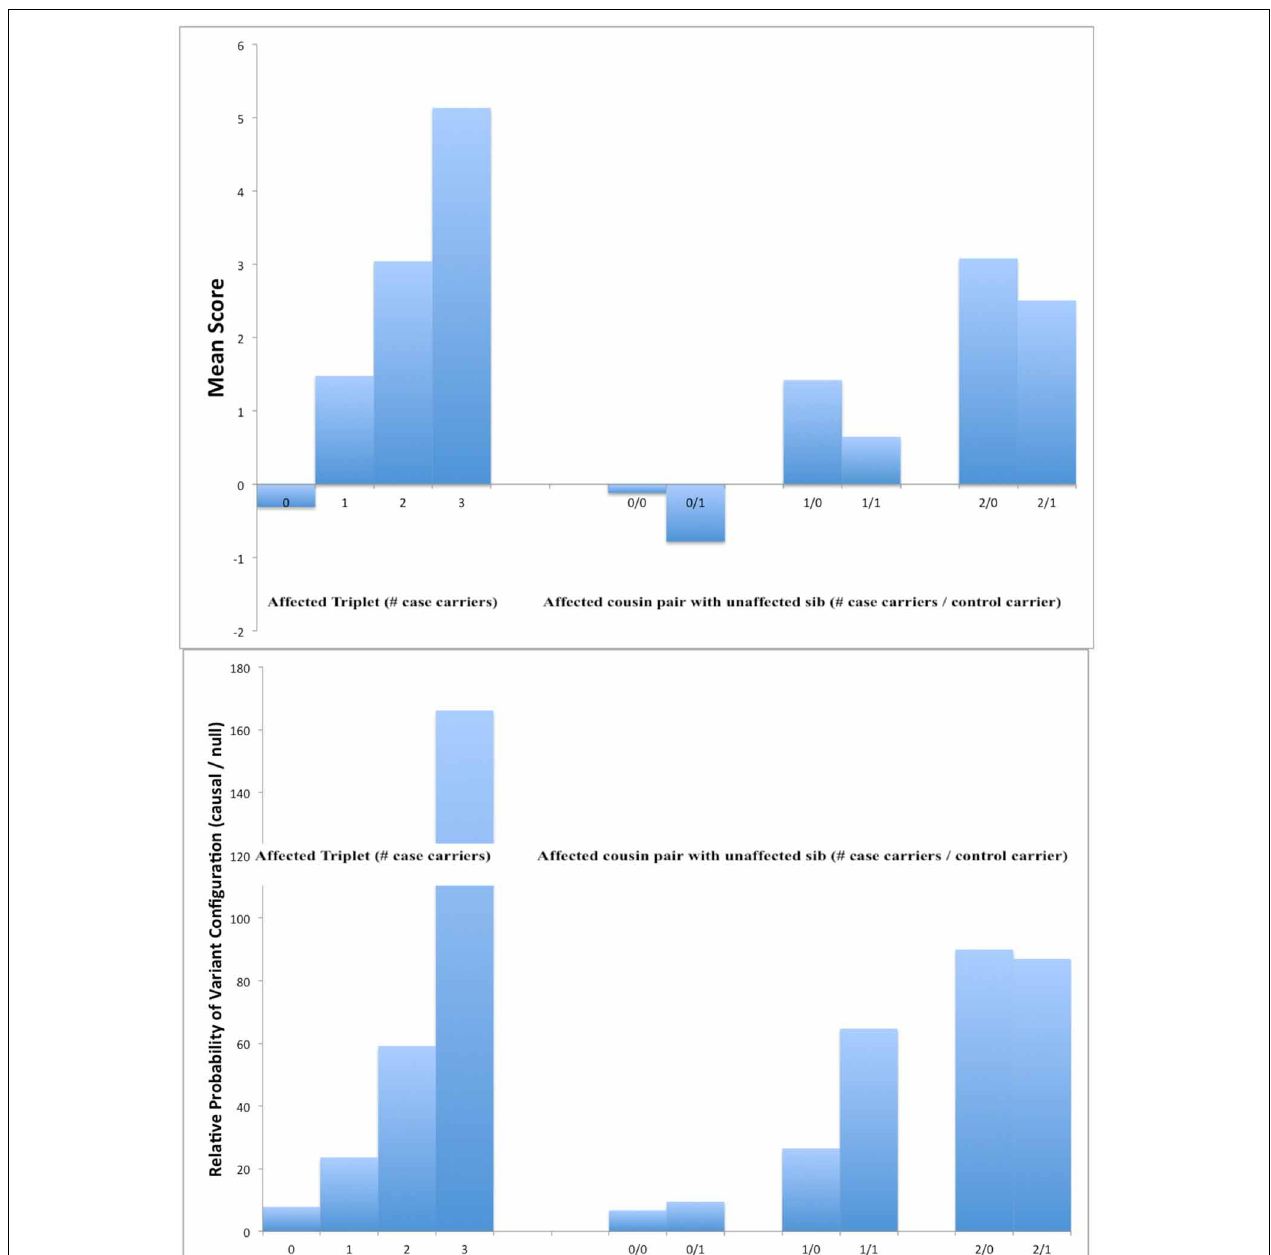
FIGURE 1 | Mean scores for causal variants (top panel) and ratio of frequencies of causal to non-causal variants (bottom panel) in simulated 11-member pedigrees with at least 4 affected members. In each panel, results are shown for a design